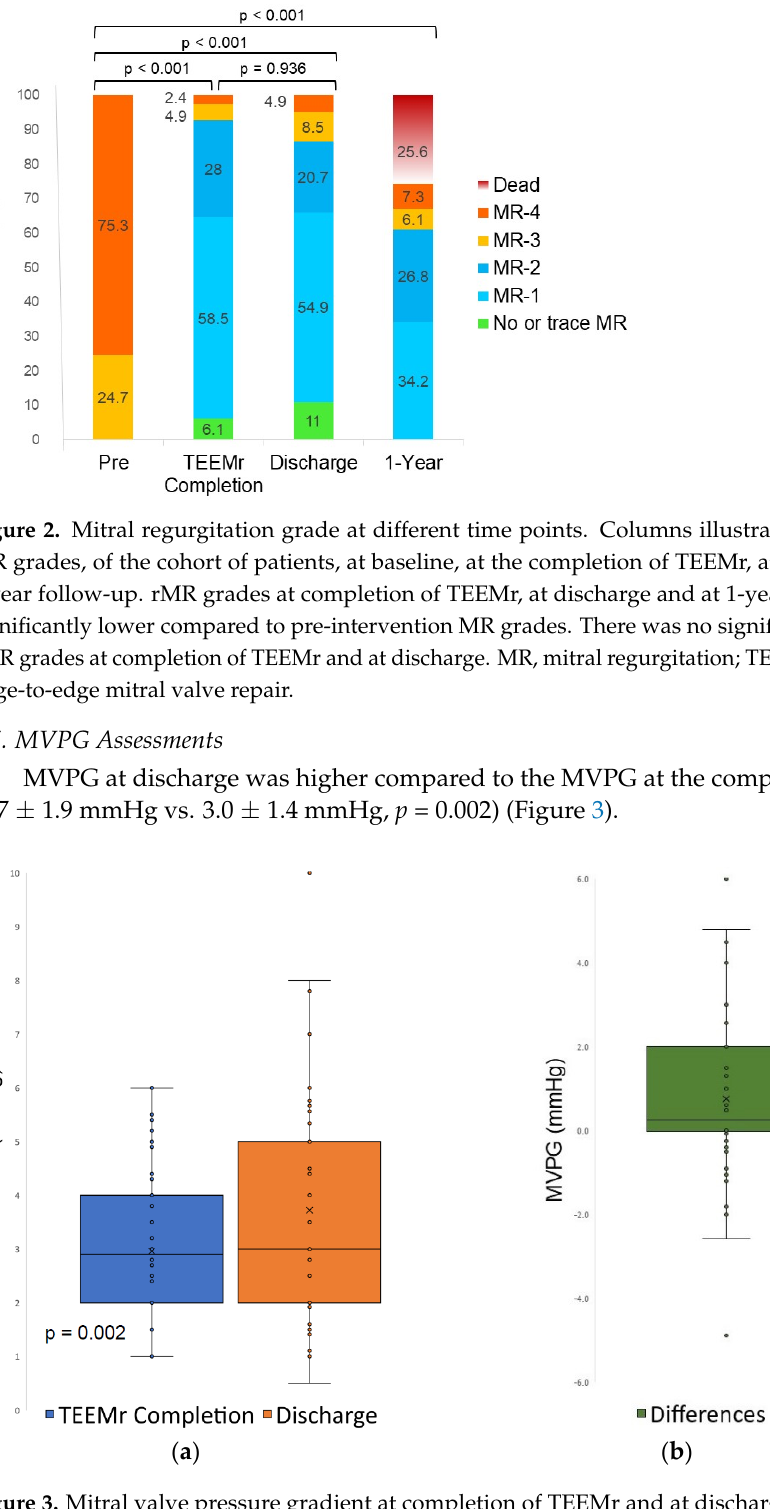
Figure 1. Changes in NYHA Functional class at baseline and at 3-Month, 6-Month and 1-Year after TEEMr.